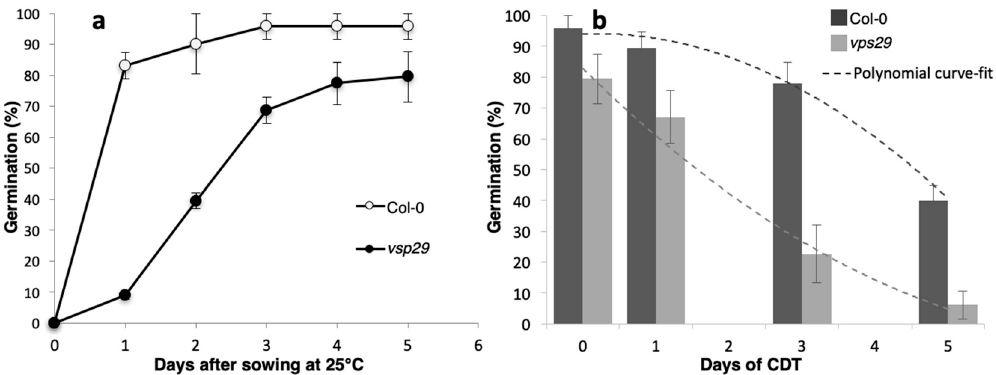
Figure 1. Impact of the loss of retromer function on seed germination and longevity. ( a ) Germination curve of Col-0 and vps29 Arabidopsis seeds after cold stratification treatment (5 days at 4 °C in the dark) and subsequent transferral to continuous light at 25 °C. Seed germination (considered as radicle protrusion through the seed coat and the endosperm) was scored daily. White circles represent the germination means for Col-0 seeds. Black circles represent the germination means for vps29 seeds. The bars represent the standard deviation (±SD) of the mean of three independent experiments. ( b ) Influence of controlled deterioration treatment (CDT) on Arabidopsis seed germination. Col-0 and vps29 seeds were submitted to CDT for different periods of time (0, 1, 3, and 5 days). The graph shows the maximum percentage of germination (Gmax) of deteriorated seeds. It is a representative experiment carried out three times in triplicate. The bars represent the standard deviation (±SD) of the mean of three independent experiments. Dashed lines represent the polynomial curve-fit related to these following equations: Col-0, y = − 2.3054x 2 + 5.4464x + 90.901 with R² = 0.99037; vps29 , y = 1.5537x 2 − 26.453x + 107.67 with R² = 0.98204.